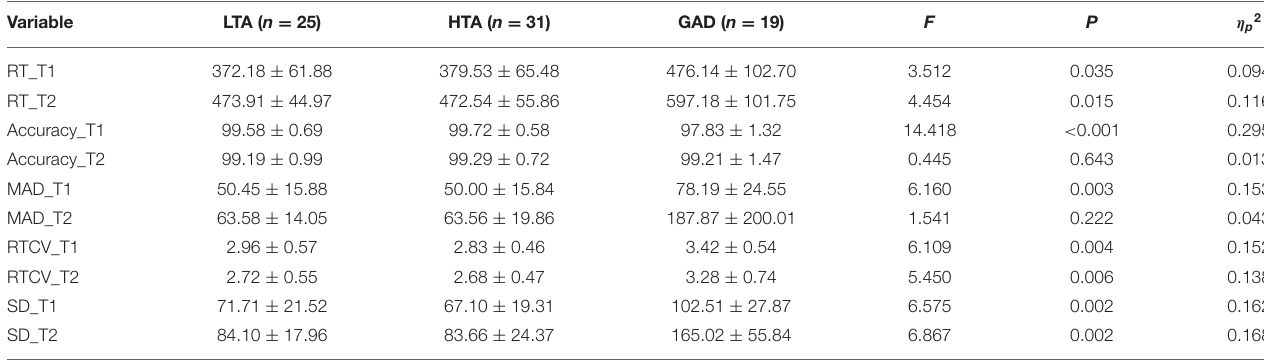
TABLE 2 | Comparison of group differences in main study